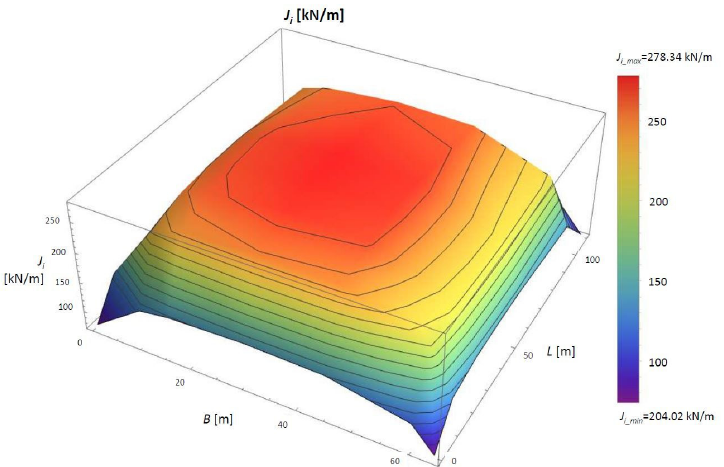
Figure 18. The values of the J i parameter for the embankment in Szczecin in the 3D view.